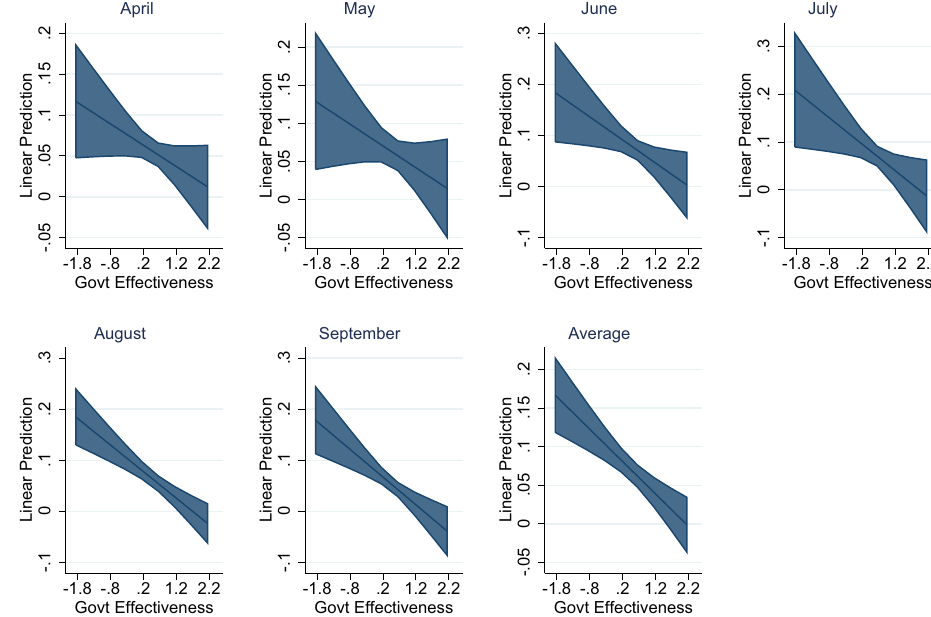
Fig. 6 Predicted values of the COVID-19 positive rate at different values of government